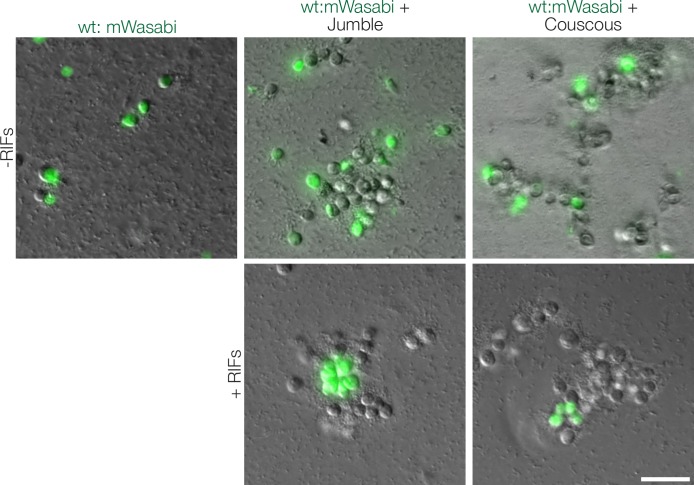
Jumble and Couscous cells adhere to wild type cells.Fluorescent mWasabi expressing wild type cells uninduced or induced to form rosettes by the addition of RIFs were mixed with either Jumble or Couscous cells and imaged after 30 min. Mutant cells adhered non-specifically to each other and wild type cells. Scale bar = 20 μm.